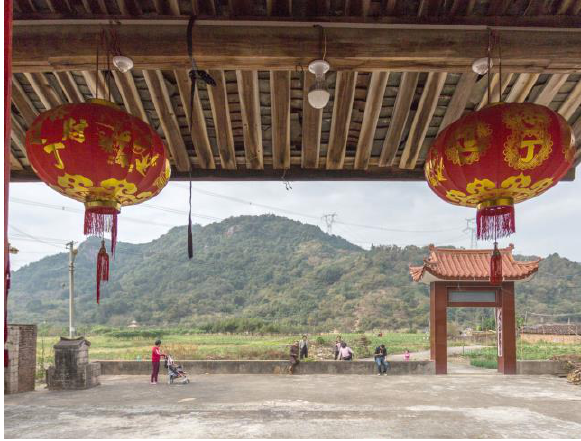
Figure 13. The front yard in front of the ancestral hall. Photo by the first author (2018).